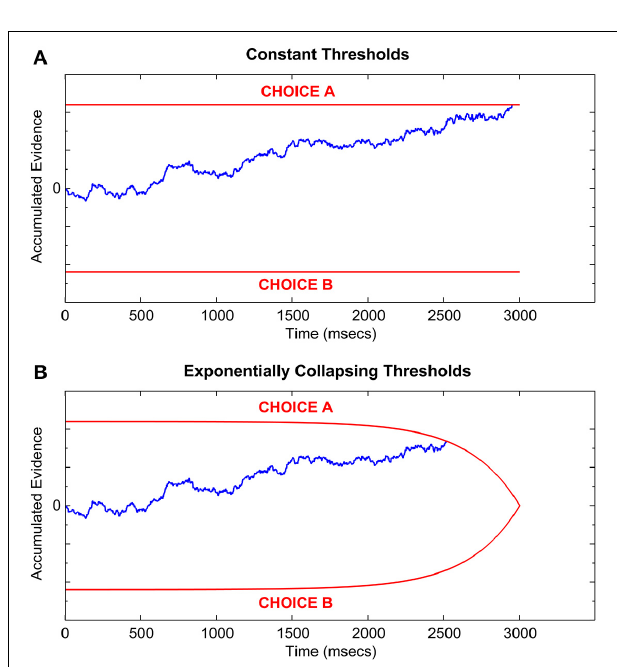
FIGURE 2 | Sample Drift-Diffusion process with (A) constant thresholds, and (B) exponentially collapsing thresholds which meet at a hypothetical deadline of 3000ms. Red lines represent the two decision thresholds; blue line represents the evidence accumulation process [identical in both (A,B) ]. Threshold crossing time represents the decision time. Total RT equals decision time plus non-decision